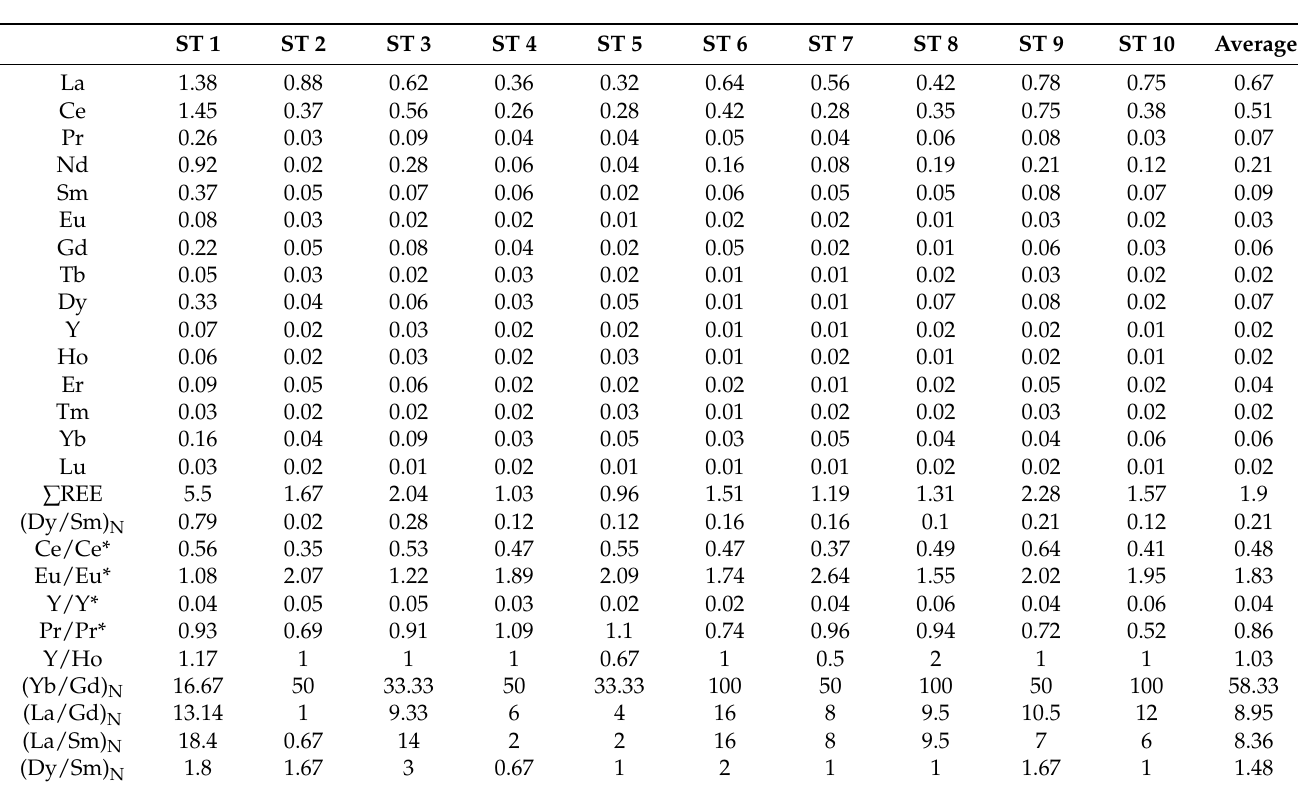
Table 5. Rare earth element (REE) contents of the stromatolites from Lake Salda, in parts per million (ppm; µ g g –1